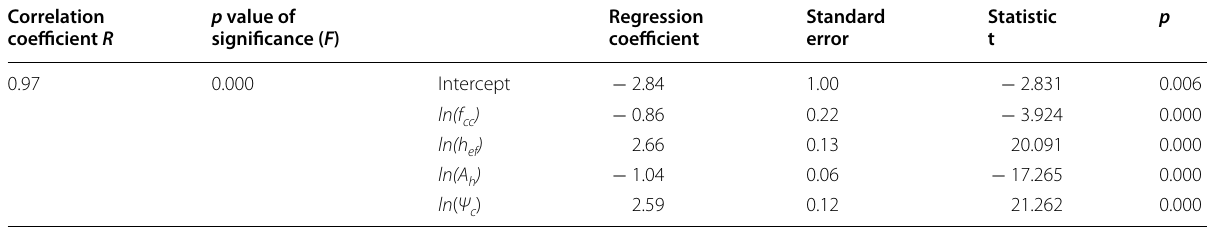
R , F , t and p are statistical values describing the results of the multiple linear regression analysis. f cc is the compressive strength of concrete cubes with side length of 200 mm; h ef is the embedment depth of the headed stud; A h is the bearing area of stud head; Ψ c is the boundary coefficient considering the influence of the free edges and group